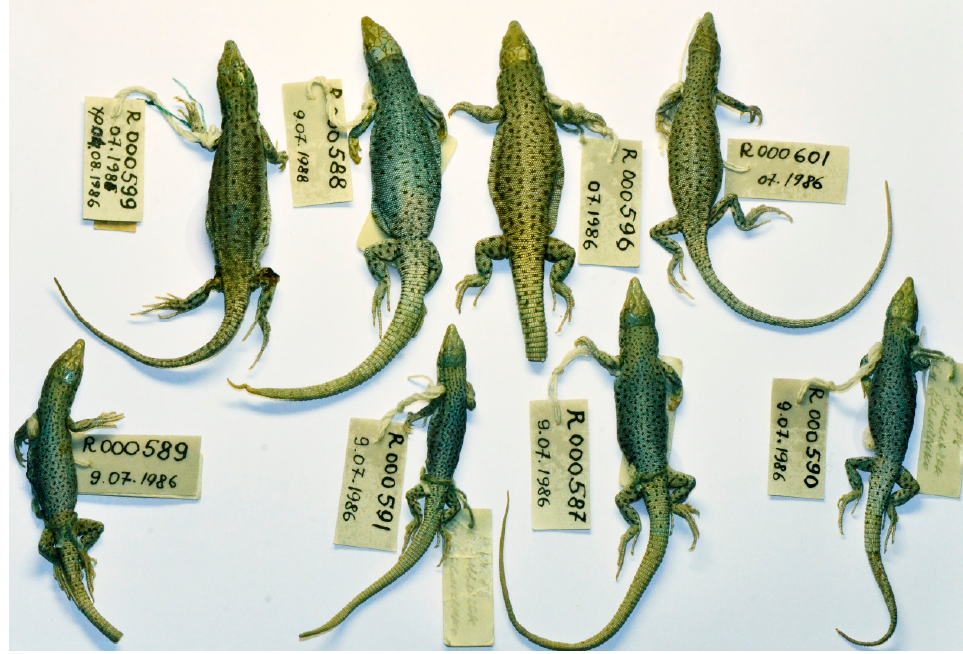
Figure 3. Paratypes of Eremias kokschaaliensis A (BSI R000587–591, 599–601) in preservative in dorsal view.